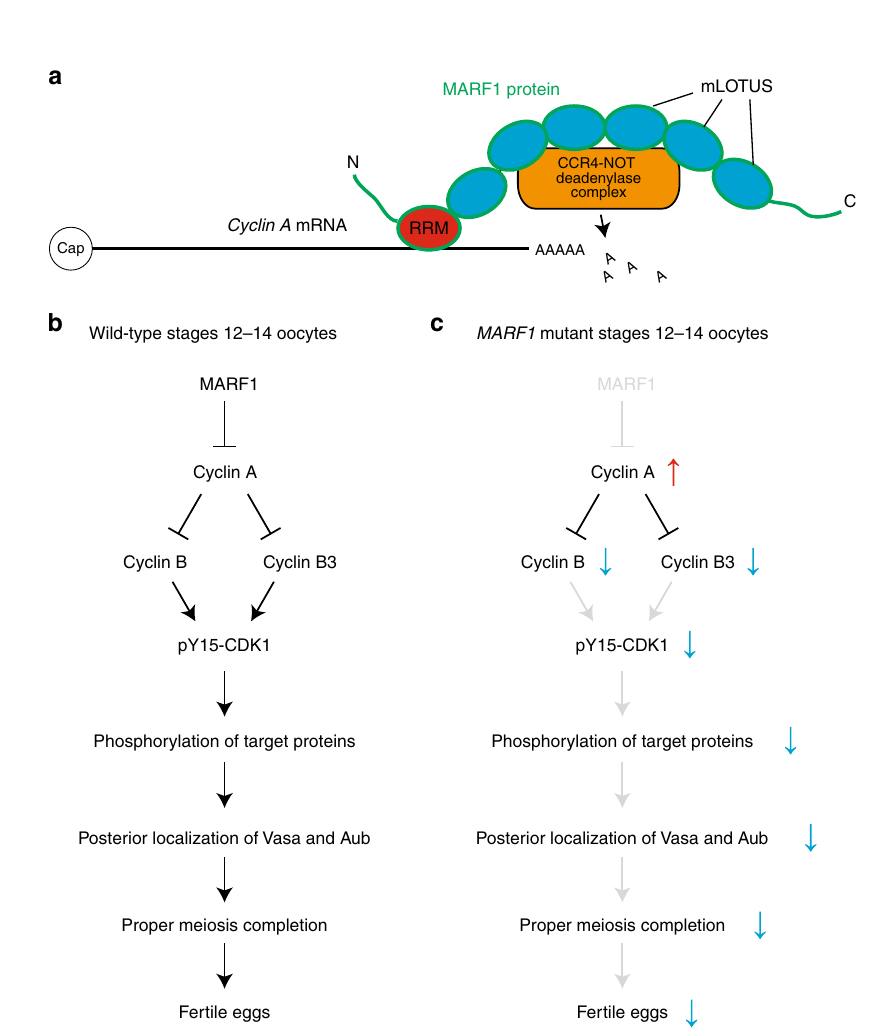
Fig. 9 MARF1 binds the CCR4-NOT deadenylase complex and cyclin A mRNA. a Co-immunoprecipitation using anti-HA antibody-conjugated beads followed by Western blotting. Ovary lysates expressing 3xHA-MARF1 (MAT67Tub-Gal4 → UASP-3xHA-MARF1) and those from w 1118 negative control were tested. b Co-immunoprecipitation using anti-HA antibody-conjugated beads followed by Western blotting. Ovary lysates expressing 3xHA-tagged MARF1 (MAT67Tub-Gal4 → UASP-3xHA-MARF1 full-length or fragments) and those from w 1118 negative control were tested. Black triangles indicate the detected 3xHA-tagged MARF1 proteins. c Co-immunoprecipitation using ovary lysates from w 1118 and anti-Not1 antibody or negative control IgG-bound protein G beads followed by Western blotting. d Fold enrichment of mRNAs relative to a control gapdh mRNA that were co-immunoprecipitated with MARF1 by anti-HA antibody-conjugated beads and were eluted from the beads normalized by w 1118 negative control, determined by RNA- immunoprecipitation followed by qRT-PCR. Mean ± SD ( n = 3). P -value < 0.05 (Student ’ s t -test) is indicated by *. e ePAT assay to determine the poly-A length of cyclin A and cdk1 mRNAs in control w 1118 and MARF1 null stage 14 oocytes. The ampli fi ed DNA sizes determined by the capillary fragment analysis. Poly-A length of cyclin A mRNA, but not cdk1 mRNA, is longer in MARF1 null stage 14 oocytes than in control stage 14 oocytes